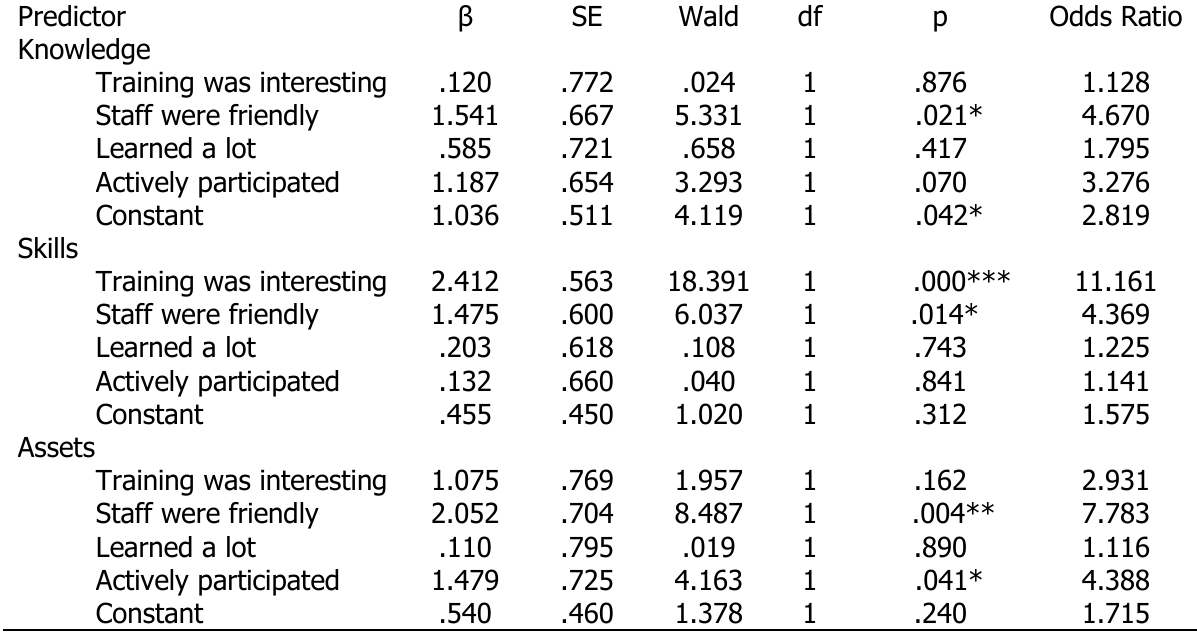
Binary Logistic Regression Coefficients of Program Outcomes on Engagement